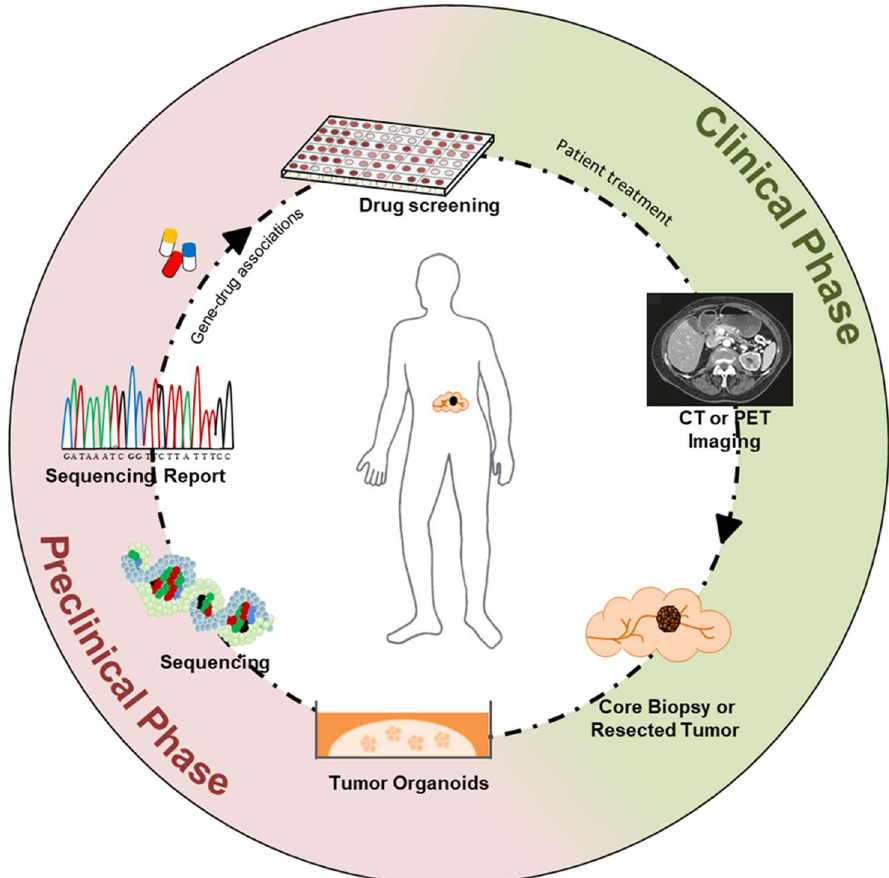
Figure 1. Patient-derived organoids for personalized cancer therapy. Integration of preclinical and clinical activities into a process that revolves around the patient. Patient-derived tumour organoids are rapidly established from core biopsies or resected tumour tissues. Sequencing (both DNA and RNA) is performed on organoid cultures to capture genomic and phenotypic features of the tumour, and to nominate possible therapeutic approaches. Drug-testing is performed to prioritize therapeutic intervention for the patient. Patient response to the selected treatment is evaluated also by imaging. Clinical data obtained pre- and post-treatment flow into databases that might be useful to guide further preclinical investigations. With the possibility of establishing organoid cultures from small biopsies, longitudinal sampling of the tumour also provides the opportunity for reiteration of the process.